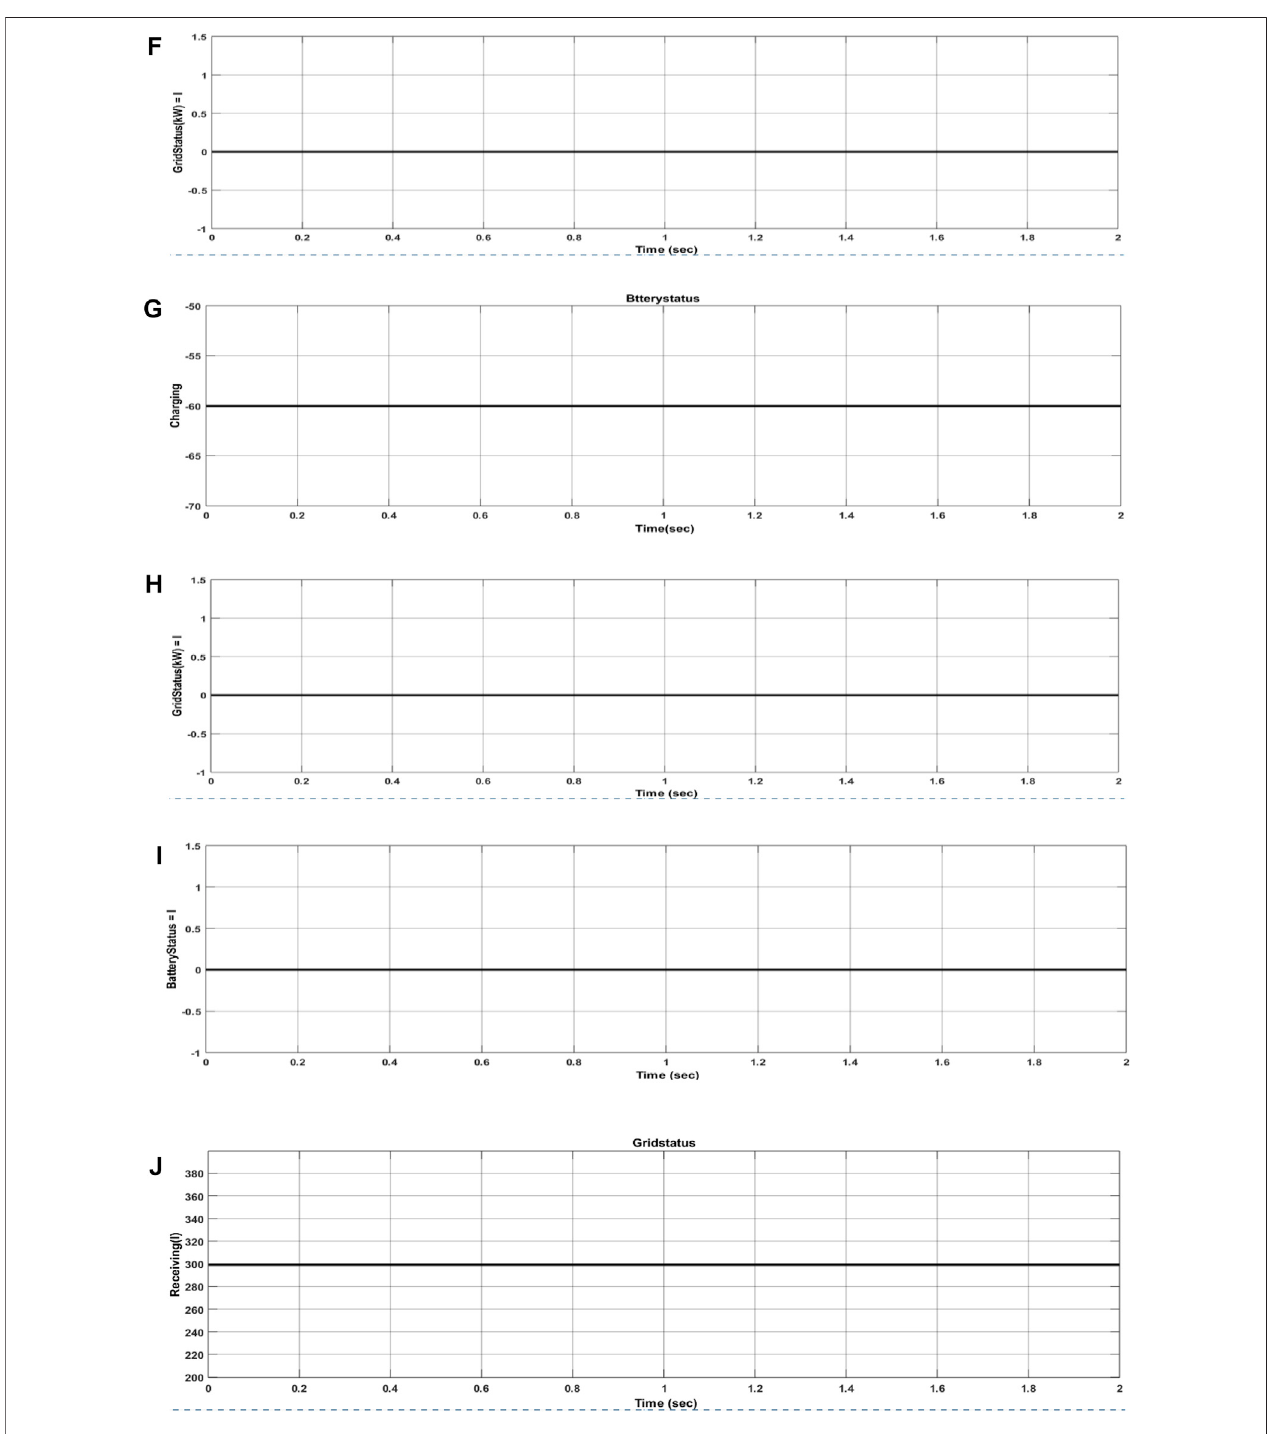
FIGURE 10 | (A) Battery status with time when bus voltage is below 480V dc , (B) Grid status with time when bus voltage is below 480V dc , (C) Battery status with timewhenbusvoltageisinbetween480V dc and 490V dc , (D) Gridstatus withtimewhenbusvoltageisinbetween480V dc and490V dc , (E) Batterystatuswithtimewhen bus voltage is 500 V dc , (F) Grid status with time when bus voltage is 500 Vdc, (G) Battery status with time when bus voltage is in between 510 and 520 Vdc, (H) Grid statuswithtimewhenbusvoltageisinbetween510and520Vdc, (I) Batterystatuswithtimewhenbusvoltageisabove520V dc (J) Gridstatuswithtimewhenbus voltage is above 520 V dc .